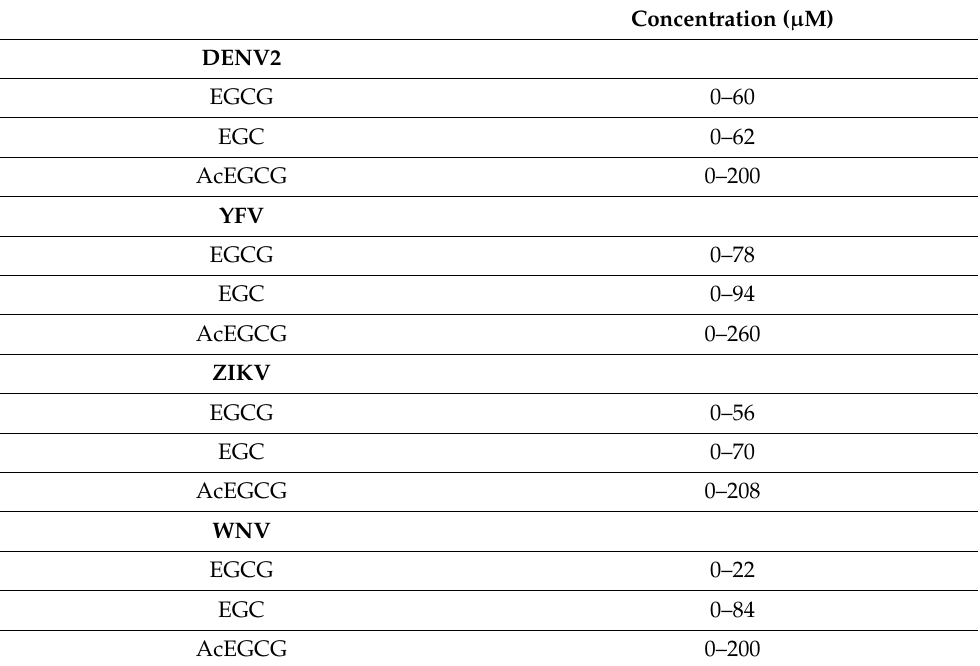
Table 3. Epigallocatechin molecules concentration range used in fluorescence